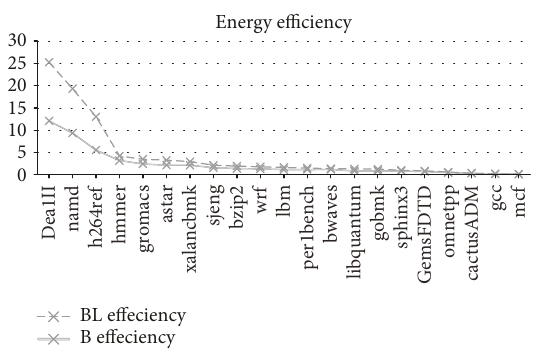
Figure 9: Energy e ffi ciency of applications in the bu ff ered (B) and bu ff erless (BL)